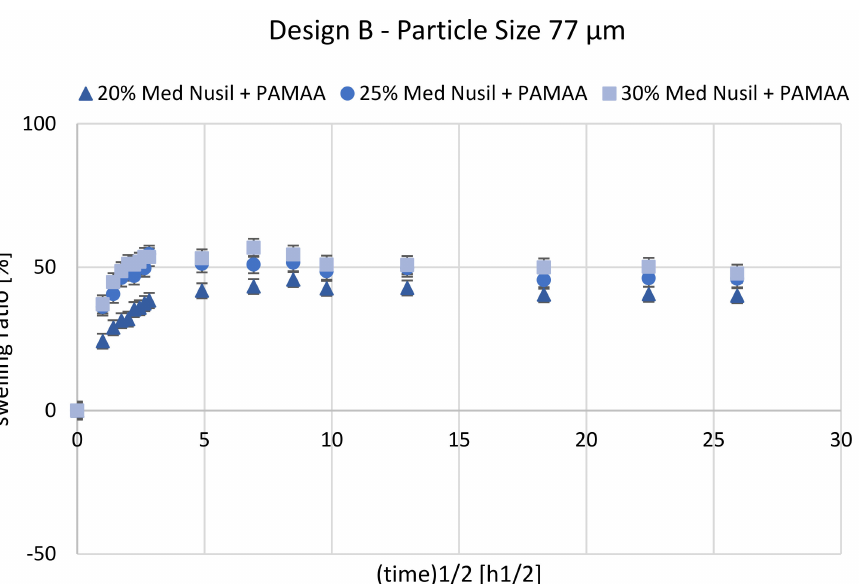
Figure 8. Mean swelling ratio over square root of time (total swelling time: 672 h) for Nusil Med 4850-PAMAA composite design B samples with initial hydrogel concentration of 20 wt%, 25 wt%, and 30 wt%. Error bars indicate standard deviation for test samples with hydrogel particle size (median) of 77 µ m. For each material combination, n = 6 samples were